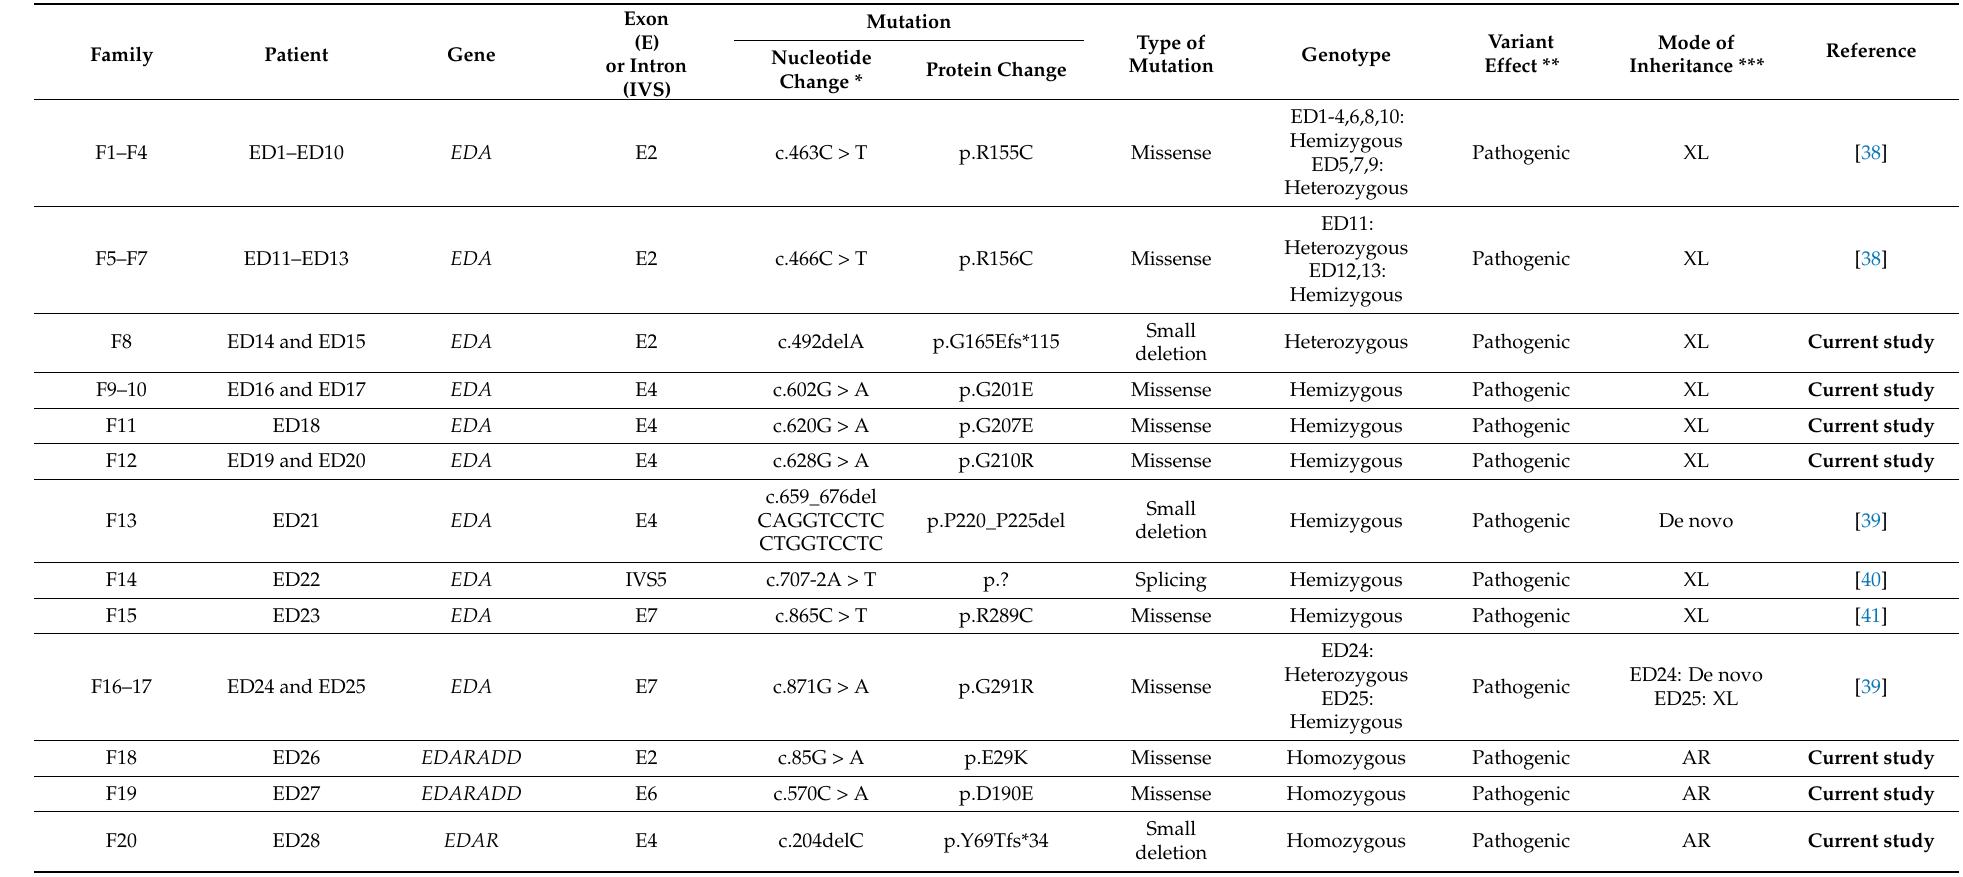
Table 3. Mutations identified in 20 ED